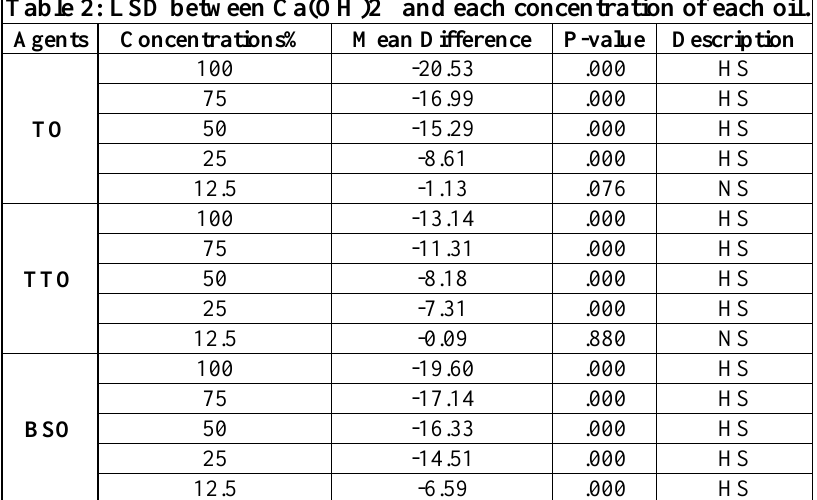
Table 2: LSD between Ca(OH)2 and each concentration of each oil. Agents Concentrations% Mean Difference